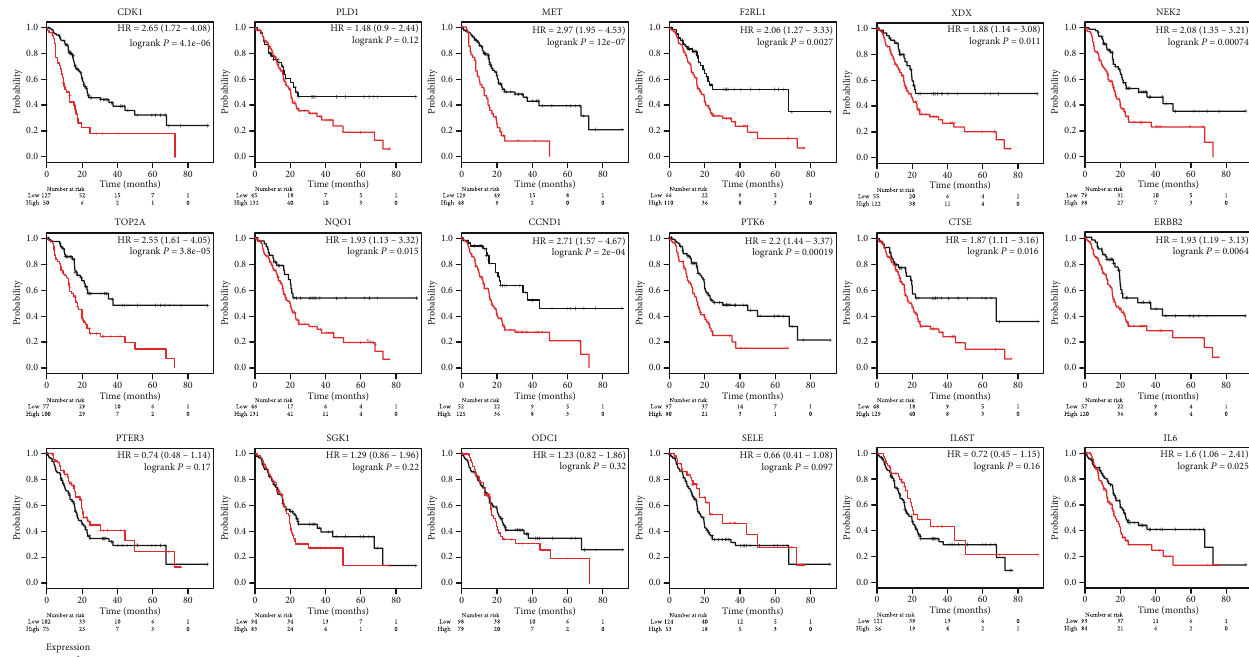
Figure 7: The prognostic value of 18 overlapped DEGs in PDAC patients. The overall survival rate of CDK1 (a), PLD1 (b), MET (c), F2RL1 (d), XDH (e), NEK2 (f), TOP2A (g), NQO1 (h), CCND1 (i), PTK6 (j), CTSE (k), ERBB2 (l), PTER3 (m), SGK1 (n), ODC1 (o), SELE (p), IL6ST (q), and IL